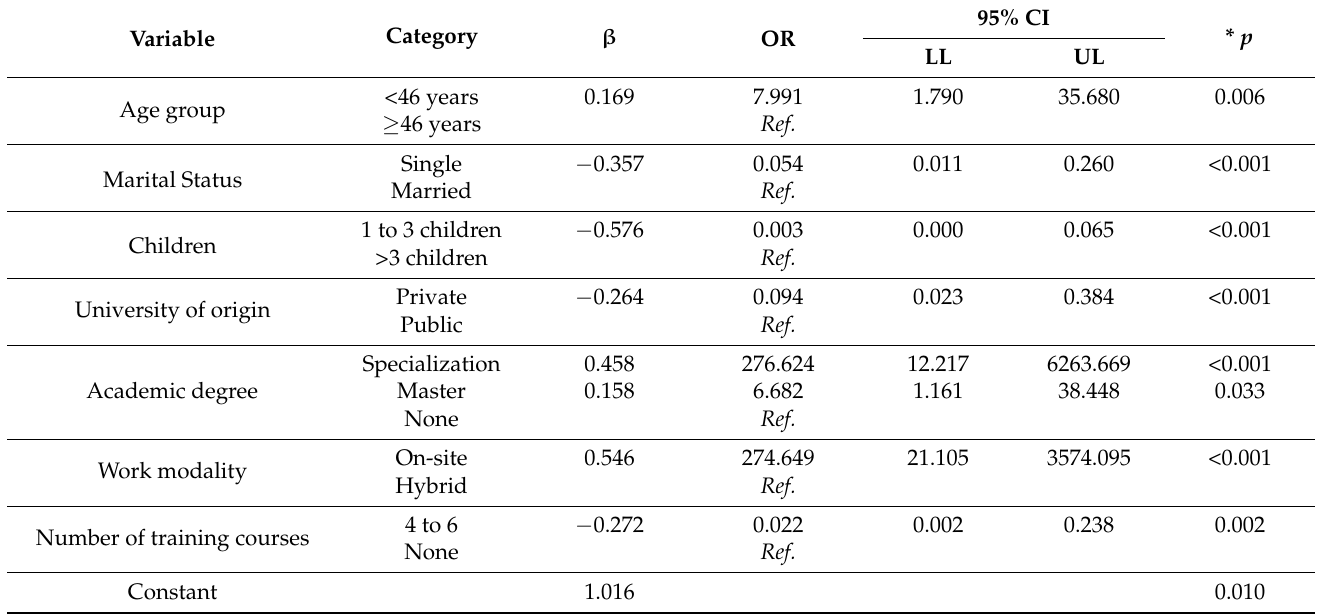
Table 4. Logistic regression analysis of the overall knowledge of DIRIS Lima Norte dentists about